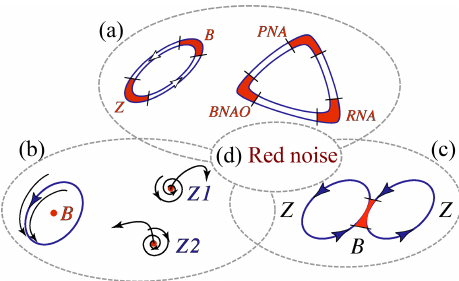
Figure 1. Schematic overview of atmospheric low-frequency vari- ability (LFV) mechanisms. Reprinted from Ghil et al. (2018), with permission from